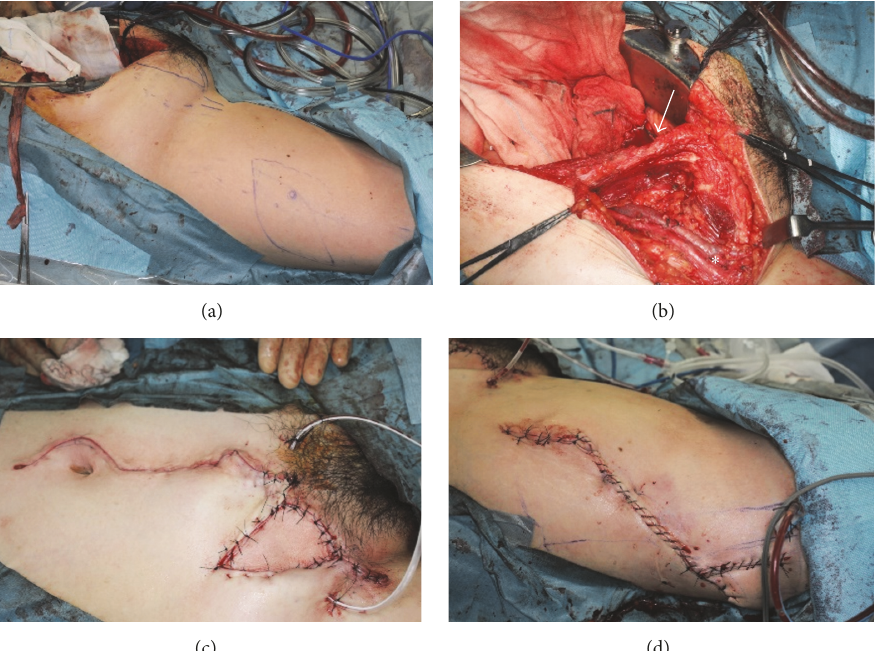
Figure 3: Tumor resection and reconstruction. (a) Skin markings on the right groin and femur. (b) Removal of the tumor with the abdominal wall (the arrow indicates the abdominal rectus and the asterisk the femoral vessels). (c) Reconstruction of the abdominal wall with a tensor lata muscle flap. (d) Femur site wound closure.